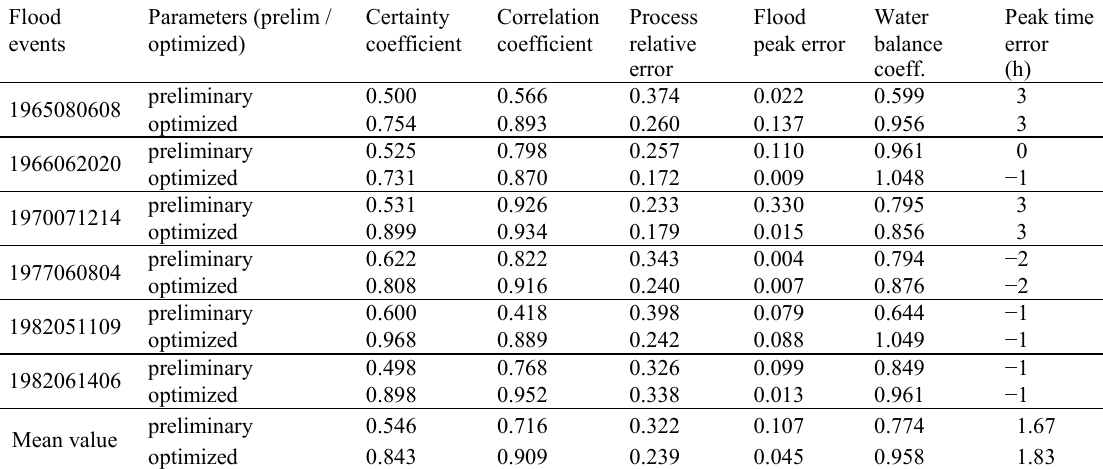
Table 4 Flood simulation results with optimized